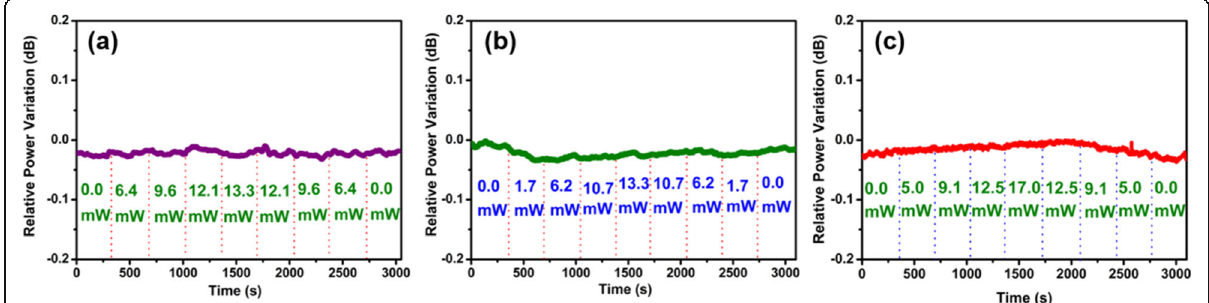
Fig. 7 TOP changes with different pump powers under a 405-nm laser, b 532-nm laser, and c 660-nm laser